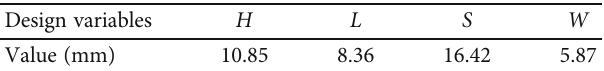
Table 5: The optimal geometric dimensions.